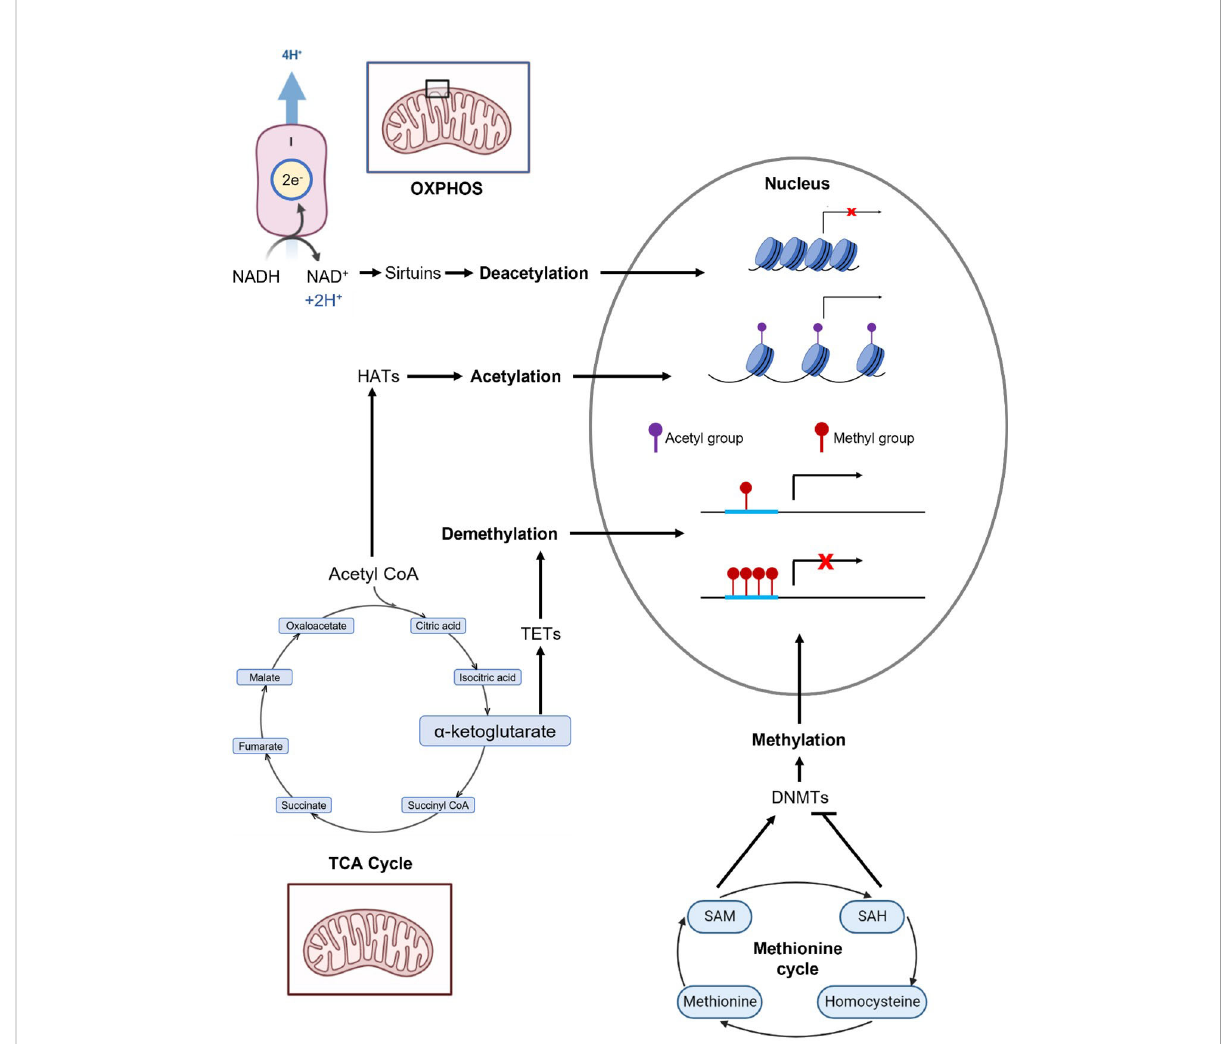
FIGURE 1 Overview of metabolic pathways that generate selected epigenome-modifying metabolites: methionine, S-adenosylmethionine (SAM), S- adenosylhomocysteine (SAH), a-ketoglutarate (aKG), acetyl CoA, and NAD+. The enzymatic reactions and epigenomic modi fi cations of these metabolites are summarized in Table 1. Complex I of OXPHOS oxidizes NADH to NAD+. Acetyl CoA and aKG are metabolites of the TCA cycle. Methionine, SAM and SAH are critical components of the methionine cycle.